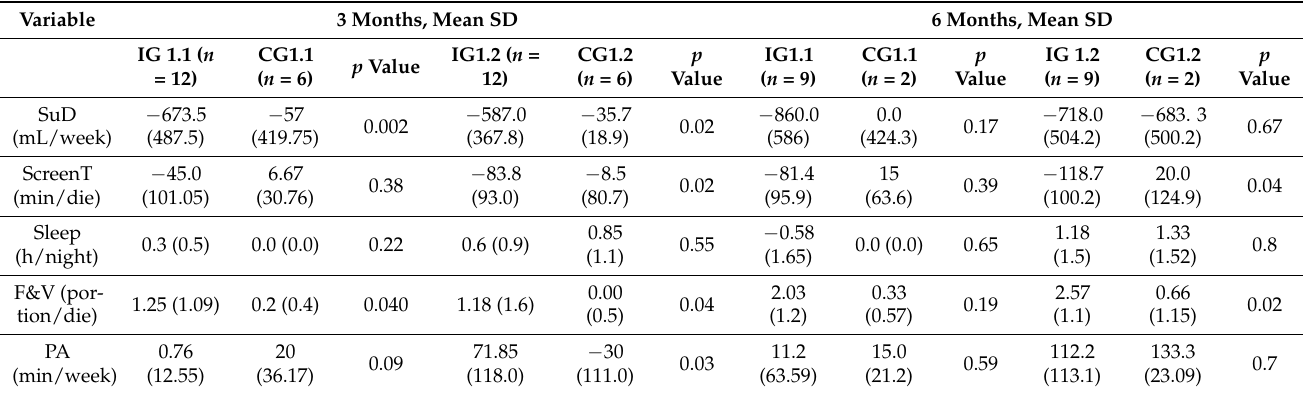
Table 4. Changes in lifestyle